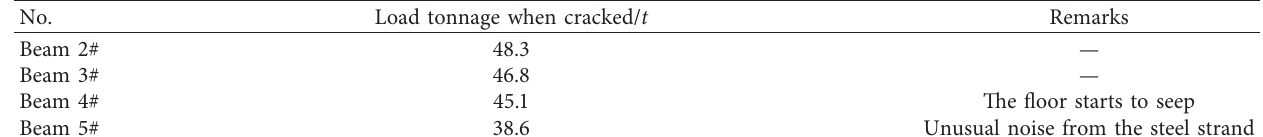
Table 10: Loads of beams with visible cracks.